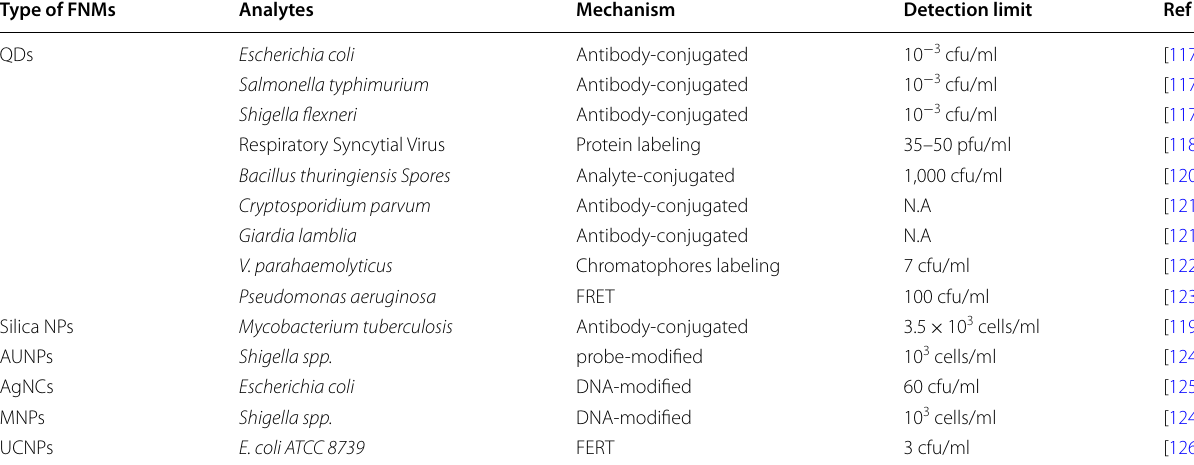
Table 2 Pathogen detection methods and properties of FNMs Type of